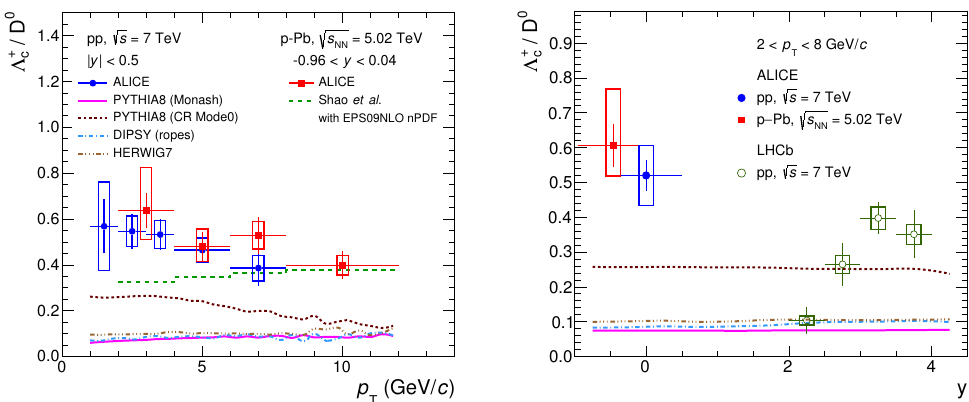
Figure 11 . The (cid:3) + /D 0 ratio measured in pp and p-Pb collisions by ALICE as a function of p T c (left) and as a function of y for 2 < p T < 8 GeV/ c (right). The measurements from pp collisions are compared with di(cid:11)erent event generators (quoted tunes for pythia and dipsy taken respectively from [17] and [18]). The p-Pb measurement as a function of p T is also compared with calculations from Lansberg and Shao [94]. The predictions from event generators as a function of y are also compared with the LHCb measurement [52,